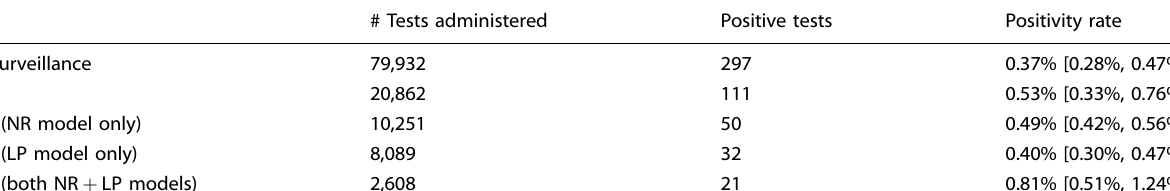
Table 1. Summary of testing results. NR and LP represent the students in the adaptive cohort who were predicted by either the node risk or link prediction model, respectively, and NR + LP represents the students who were predicted by both models.